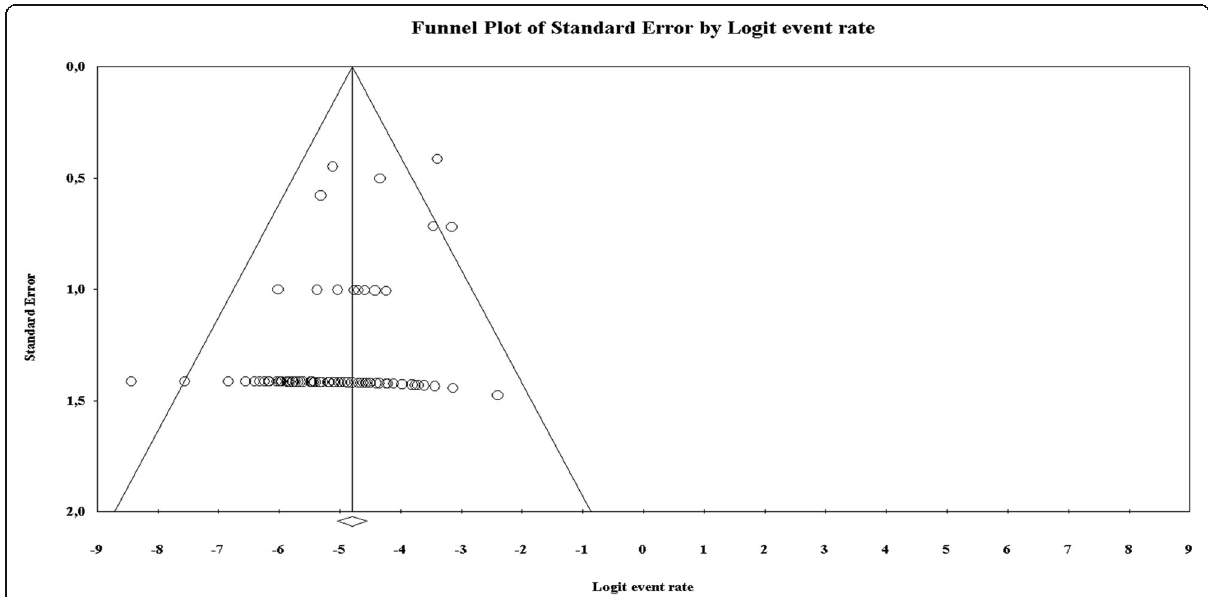
Fig. 6 Funnel plot showing risk of publication bias in articles on contrast-enhanced spectral mammography, confirmed by the Egger test ( p <0.001)